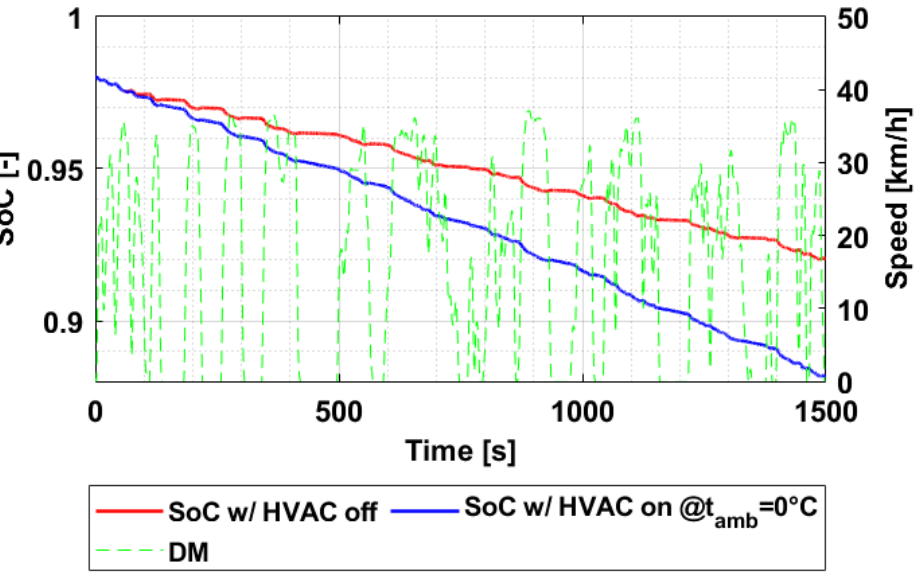
Figure 30. Evolution of the battery SoC variation with and without the HVAC system consumption for DM 20 considering the winter scenario (0 °C).